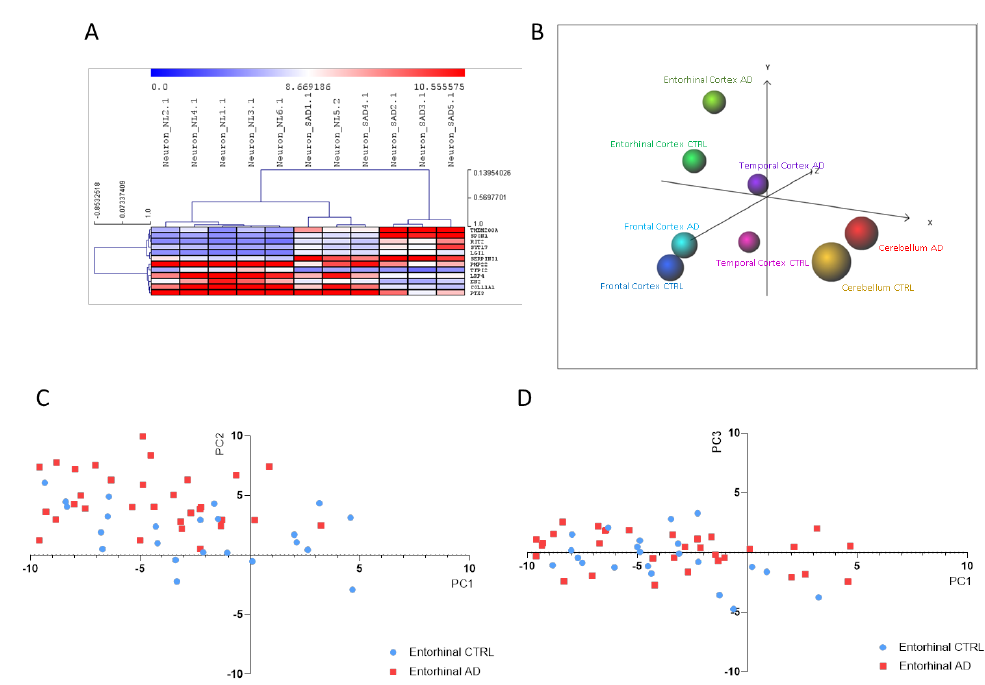
Figure 4. ( A ) Hierarchical clustering of the Alzheimer’s disease (AD) biomarkers identified using the Discriminant Analysis Module (DAM) algorithm in the Induced pluripotent stem cells (iPSCs)-derived neurons from sporadic Alzheimer’s disease patients (SAD) vs. healthy donors; ( B ) Principal Component Analysis (PCA) using the identified AD biomarkers on the samples from the GSE118553 dataset; ( C ) Scatterplot showing PC1 and PC2 for the entorhinal samples from the GSE118553 dataset; ( D ) Scatterplot showing PC1 and PC3 for the entorhinal samples from the GSE118553 dataset. Table 2. List of biomarkers identified by DAM analysis in iPSC-derived neuronal cells 1 . Gene Stable